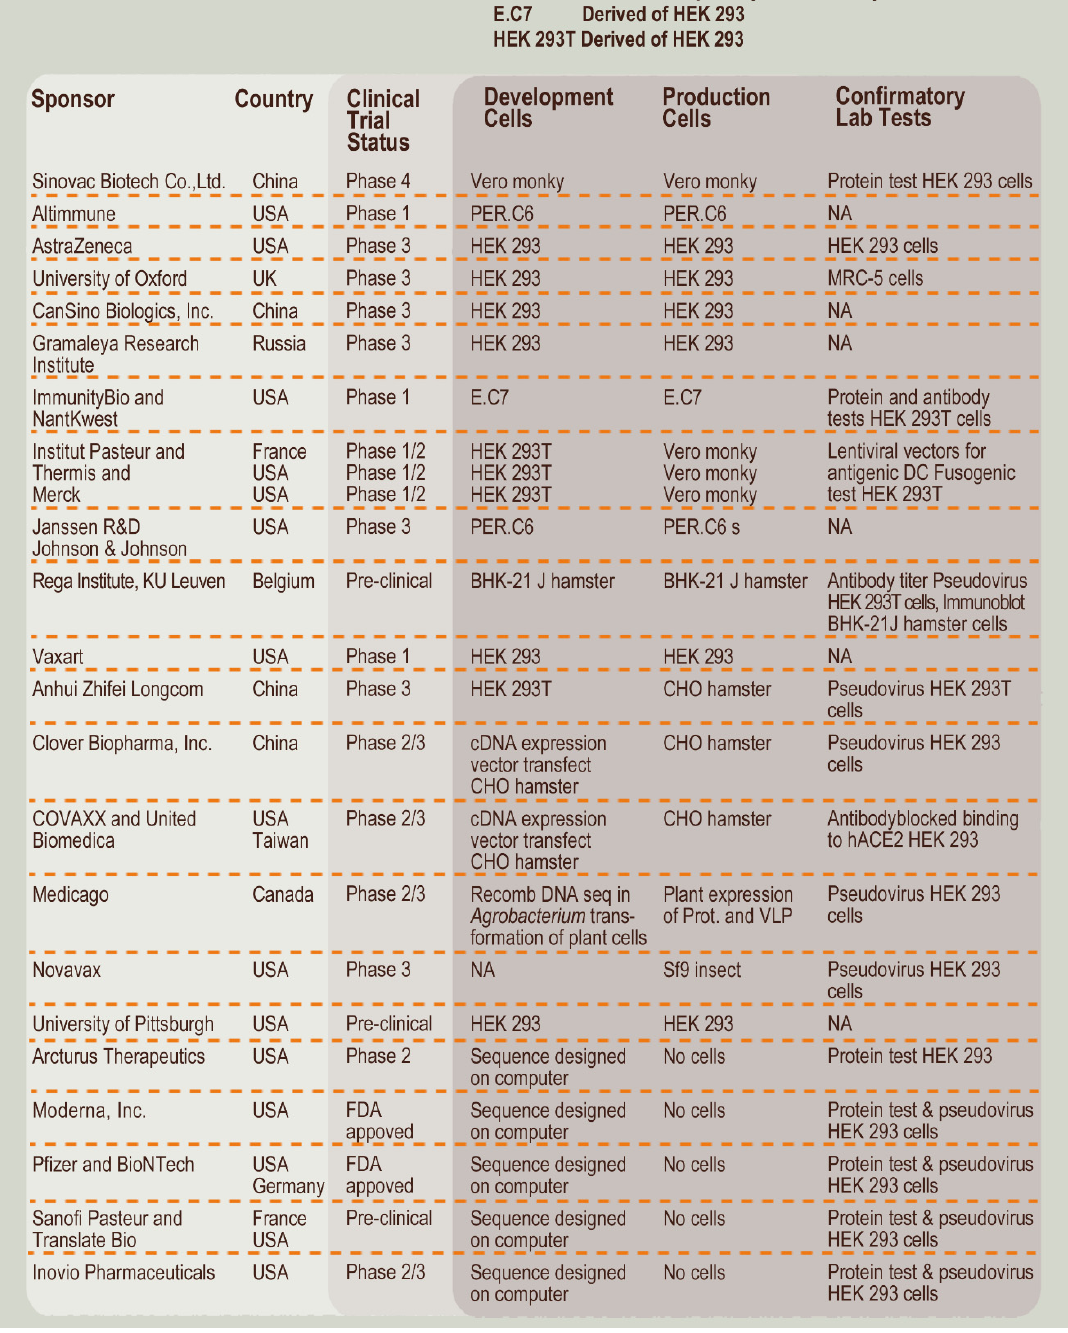
Figure 3. COVID-19 vaccine candidates and products for which prenatal-sourced cell types or cell lines are implicated in the development and/or production. Manufacturers use different cell sources for actual manufacturing and/or in quality and safety testing assays [76]. CHO, Chinese hamster ovary; DNA, deoxyribonucleic acid; FDA, US Food and Drug Ad- ministration; MRC, Medical Research Council; NA, not applicable; USA, United States of America. A major area of investigation for optimized substrate elaboration resided in the de- velopment and use of continuous cell lines, defined as immortal cells, which maintain the karyology of the original starting tissue. While some cell lines have been immortalized by